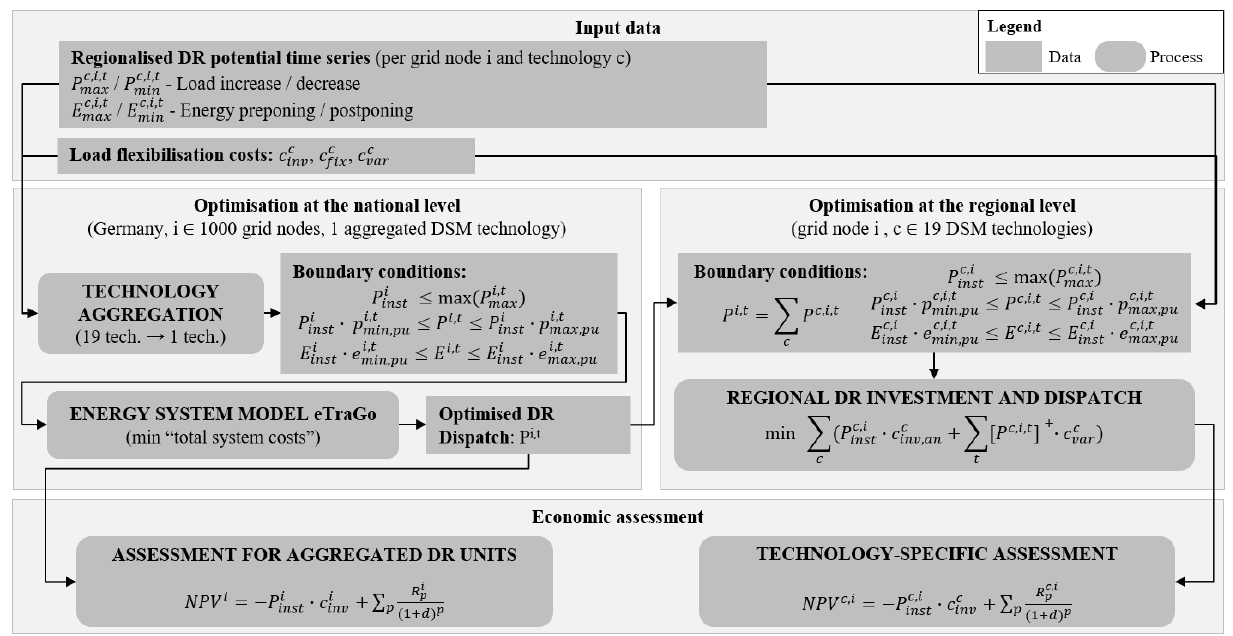
Figure 1. Overview of the used input data and the methodology applied in this work (implemented in the region4FLEX